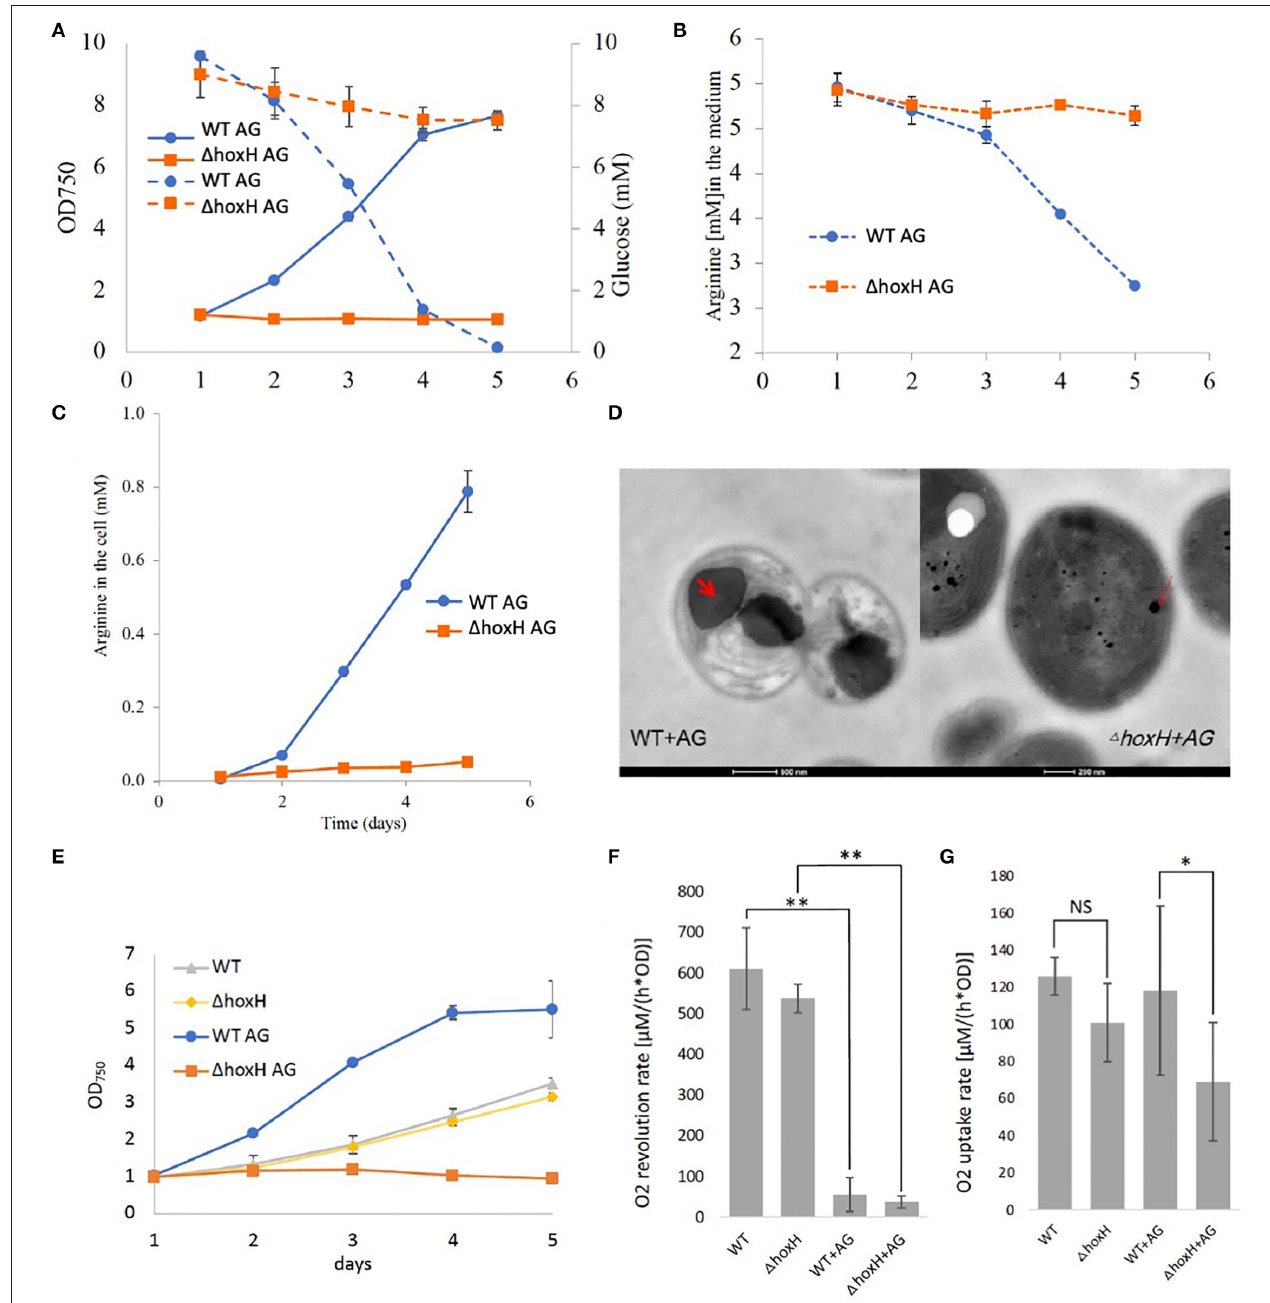
FIGURE 3 | Metabolism and morphology of WT and 1 hoxH on arginine and glucose. (A) Growth (solid line) and glucose consumption (dotted line). (B) Arginine consumption, (C) Cyanophycin content of cells displayed as arginine in the cells, (D) Transmission electron microscopy (TEM) images of WT and 1 hoxH that were cultivated on arginine and glucose. Cyanophycin granules are marked with a red arrow in the WT. (E) Growth experiment in which (F) dark respiration and (G) photosynthesis were determined by O 2 uptake and evolution on days 2–4. Stars on the column diagram indicate differences between mutant and WT by Tukey’s HSD test (* P < 0.05, ** P < 0.01). Throughout the figure ‘NS’ indicates ‘not significant’. All error bars indicate standard deviation (s.d.) of four daily independent experiments.